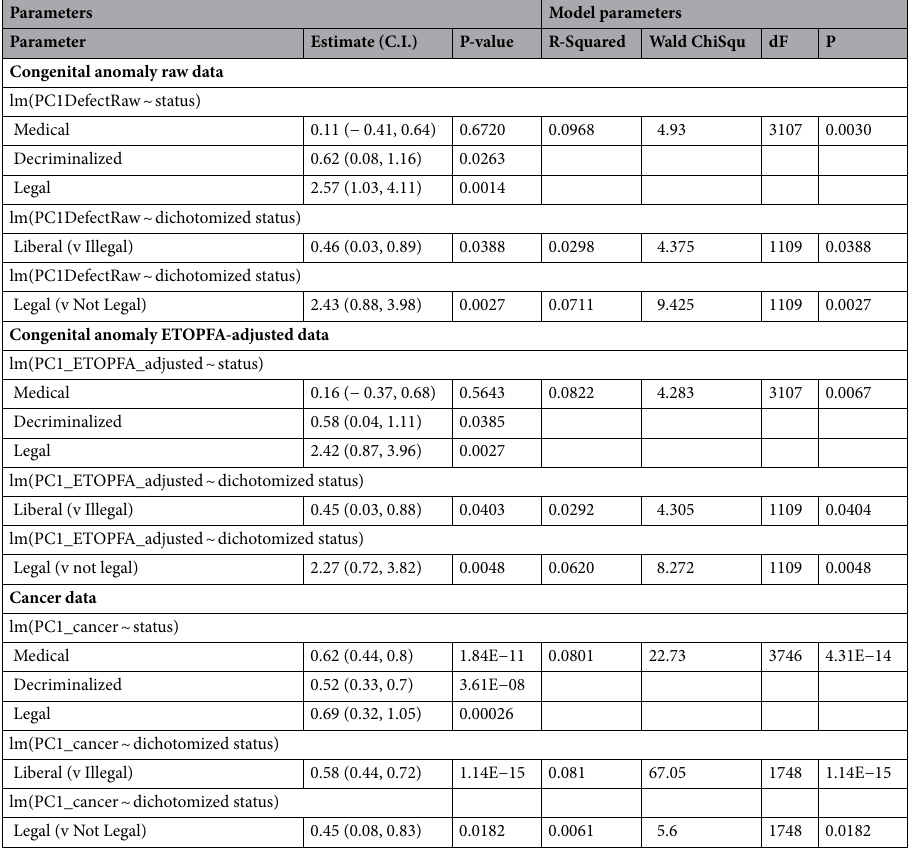
Table 6. Effects of legal status. Final linear regression models for the effects of cannabis legal status in CAR, ETOPFACAR and cancer